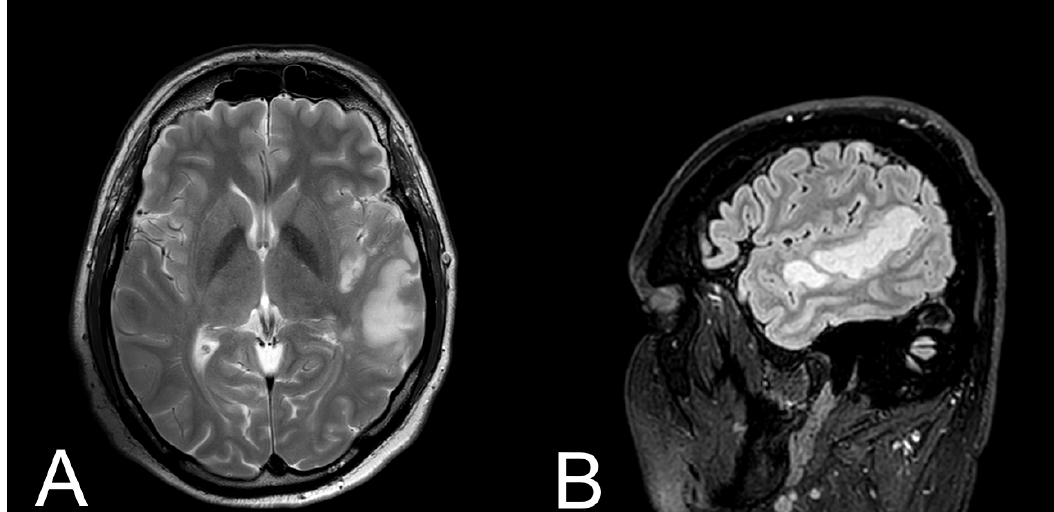
Figure 2. Initial conventional magnetic resonance imaging (MRI) of the patient. ( A ) T2-weighted image with axial plane (T2WI) showed moderate ischemic lesion in the left temporal lobe; ( B ) FLAIR image with sagittal plane showed ischemic lesion with oedema of the left temporal lobe.